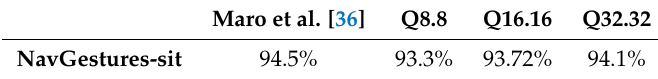
Table 2. Accuracy comparison with different numerical